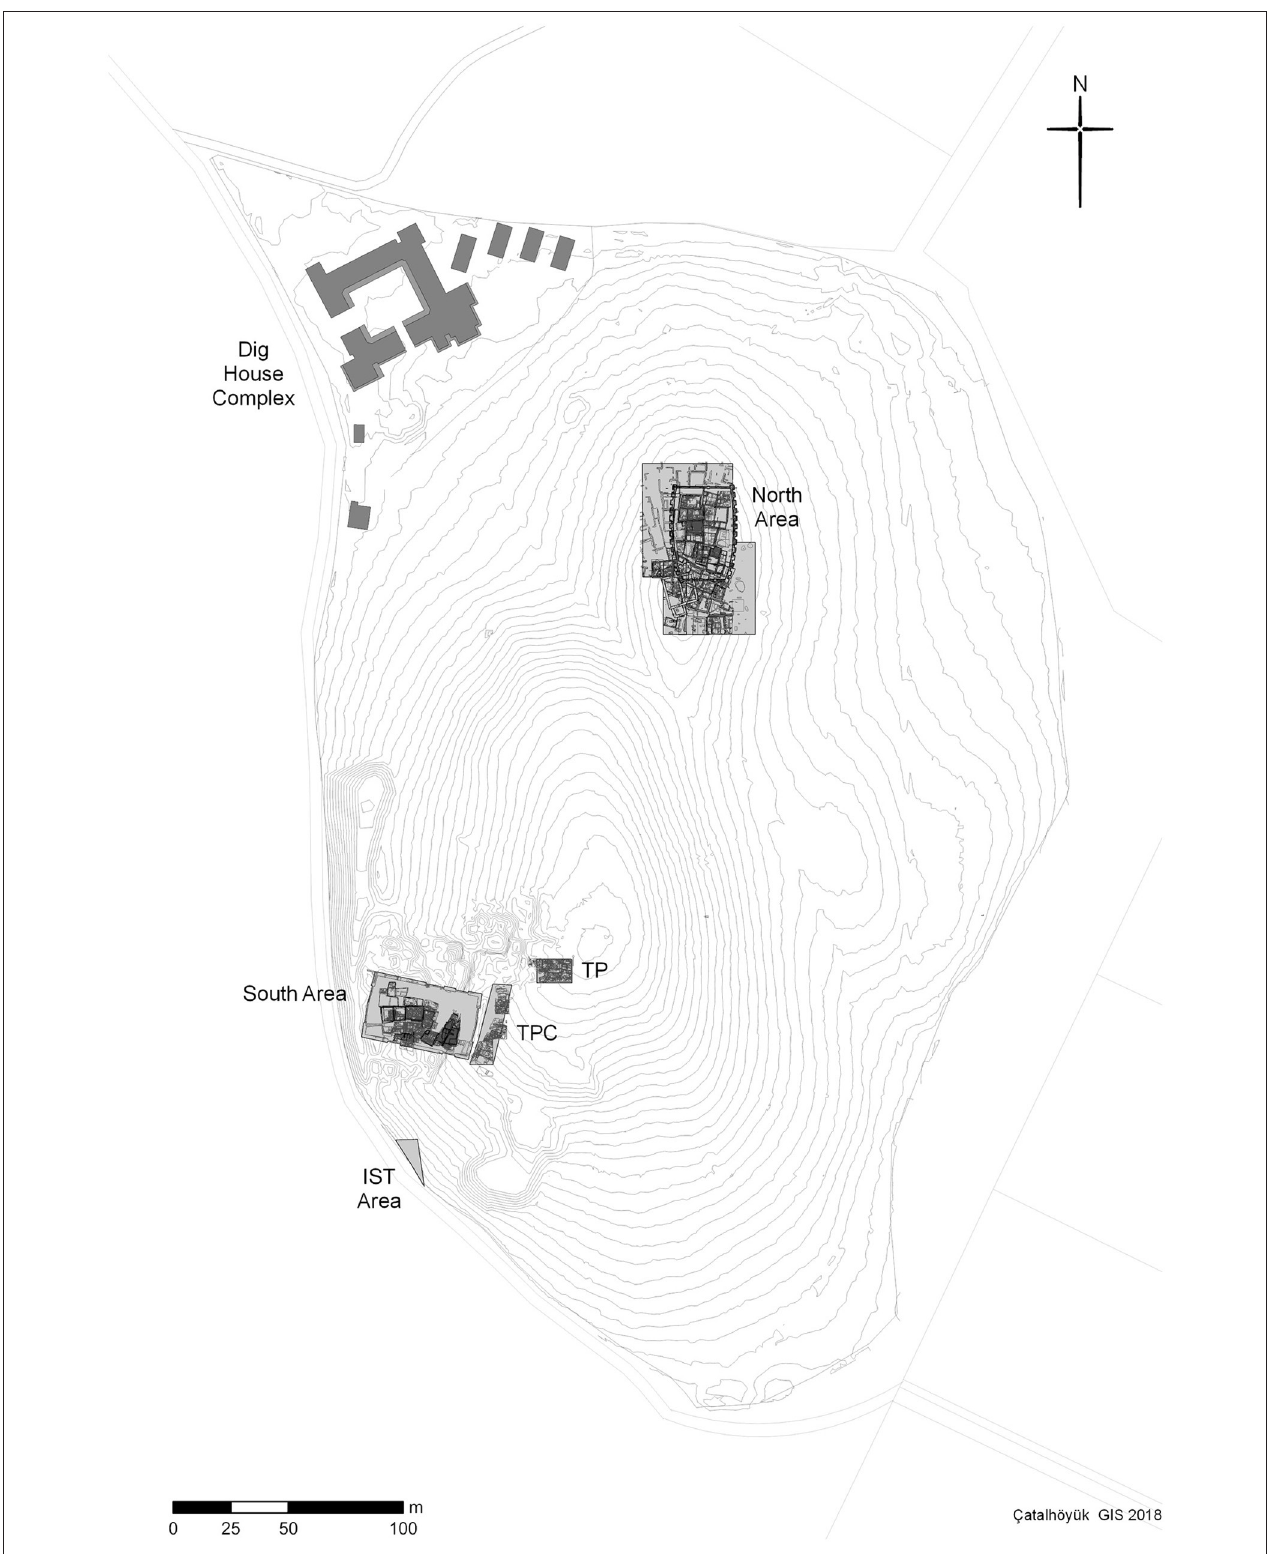
FIGURE 1 | Çatalhöyük East Mound plan. Main excavation areas highlighted in gray. (Plan: Camilla Mazzucato. Used by permission of the Çatalhöyük Research Project).